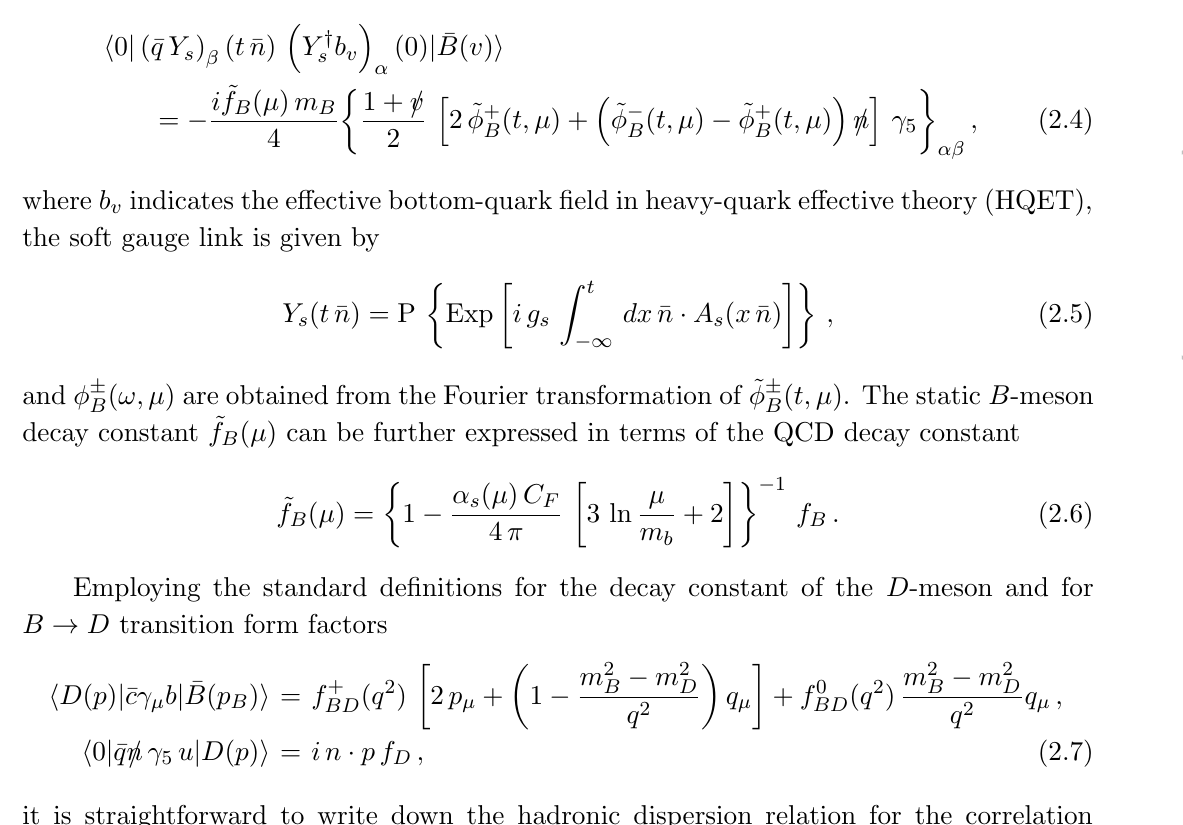
Figure 1 . Diagrammatical representation of the two-particle contributions to the vacuum-to- B - meson correlation function (cid:5) (cid:22) ( n (cid:1) p; (cid:22) n (cid:1) p ) de(cid:12)ned in (2.1) at tree level. The light-cone DA of the B -meson in the coordinate space are de(cid:12)ned as follows [34,